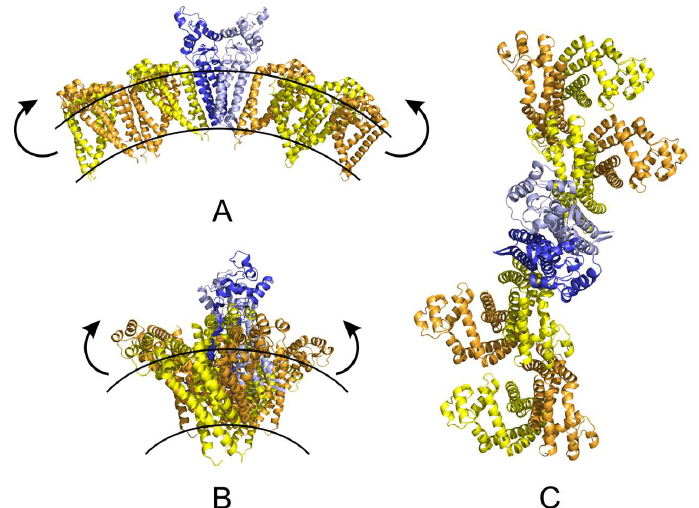
Figure 10. The proposed arrangement of the CD81/CD9 tetraspanin network. A complex CD9 and CD81 network can be formed combining the extended CD81 oligomer formed by alternating non-covalent (yellow-orange) and disulphide bridge stabilized dimers (orange-orange). A dimer of dimers is depicted for simplicity, however, longer CD81 oligomer stretches could be formed. A CD9 non-covalent dimer (shades of blue) can then interact with two such oligomers. ( A , B ) Side and front view along the CD81 oligomer stretch (a membrane—black lines—would be in horizontal orientation) showing the possible CD81/CD9 network ( C ) Top view (membrane in plane). Under low cholesterol conditions the dissociation of CD81 bound cholesterol might lead to more compact TM region within CD81 stretches changing its conical to cylindrical conformation which would result in lower area of the “upper” leaf of the bilayer and bending of the membrane (indicated with arrows in ( A , B )).